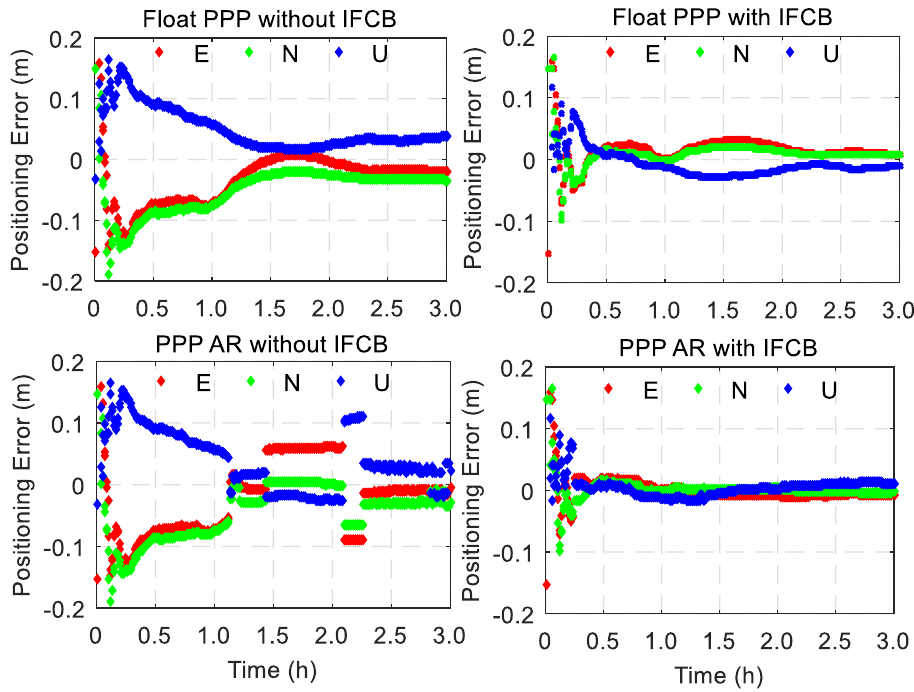
Figure 5. Three-h time series of position errors for triple-frequency static float PPP and PPP AR with or without observable-specific IFCB corrections at BRUX stations.